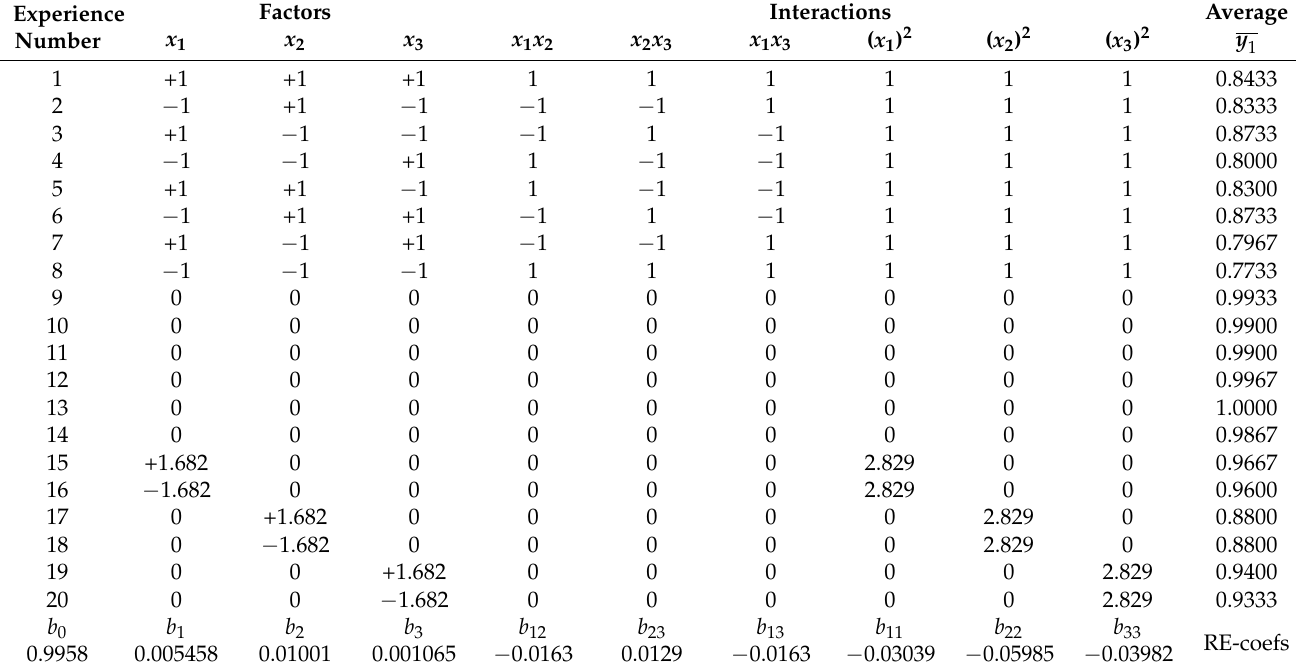
Table 4. Planning matrix with interaction effects for determining the coefficients of the regression